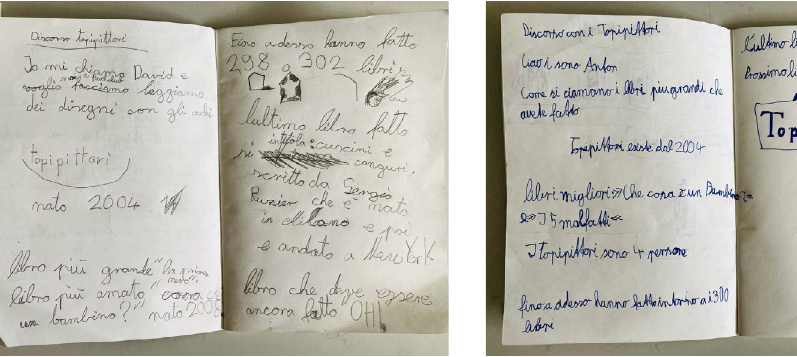
Fig. 3 Photo by Giulia Mirandola.